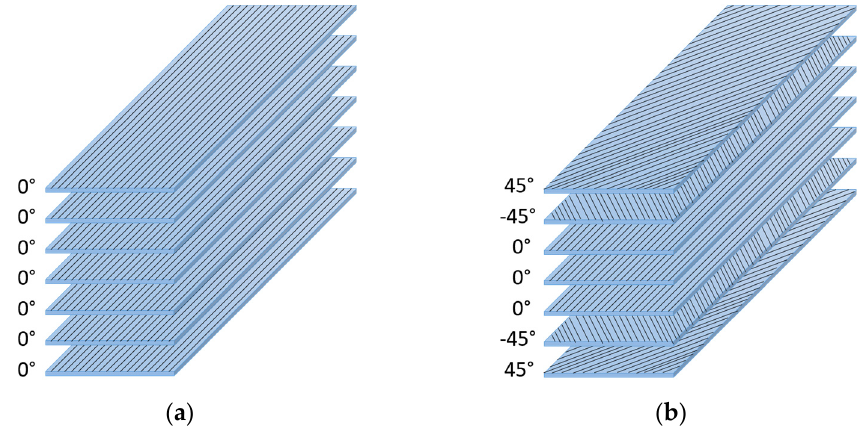
Figure 1. Sequence of the CF/PEEK films ( a ) unidirectional and ( b ) cross stacking.